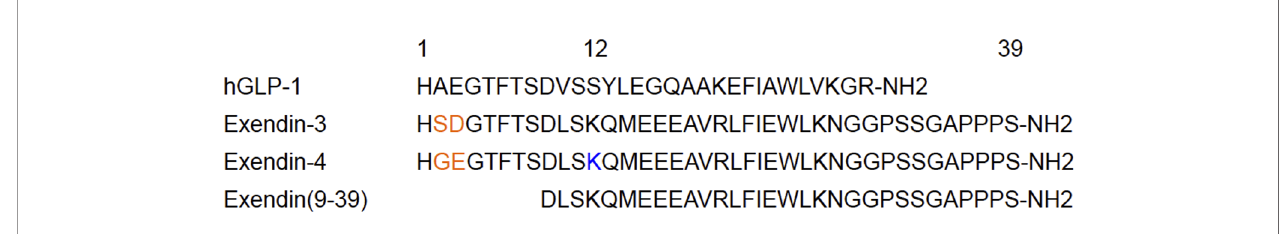
FIGURE 3 | An overview of the leading compounds for GLP-1R-targeted probes. In the development of GLP-1R-targeted imaging probes, exendin-related peptides such as exendin-3, exendin-4, and exendin (9-39) have been investigated as promising compounds. These compounds have approximately 50% homology with human GLP-1 (hGLP-1) and show high stability in vivo and high af fi nity to GLP-1R, which quali fi es their potential as tracers for in vivo b -cell imaging. Exendin-4 differs from exendin-3 by two amino acid substitutions (in orange). C-terminally modi fi ed derivatives tended to show superior speci fi city, whereas the modi fi ed derivatives on the residue Lys 12 of exendin-4 (in blue) demonstrated high af fi nity to GLP-1R and in vivo stability as in vivo imaging probes for b